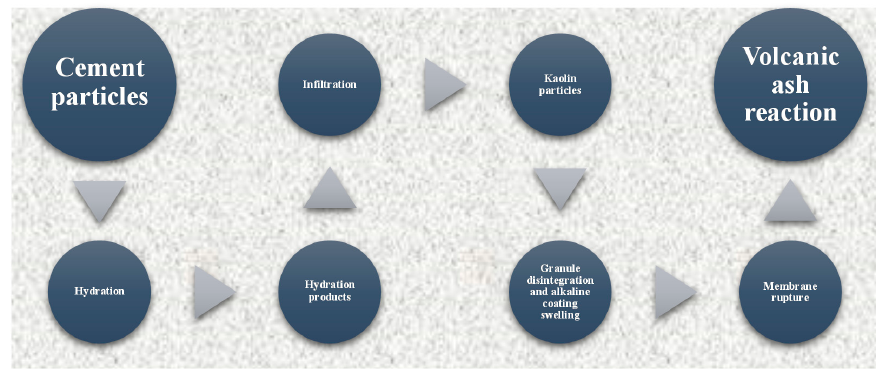
Figure 14. Pozzolanic reaction process of kaolin in the CGFB sample.